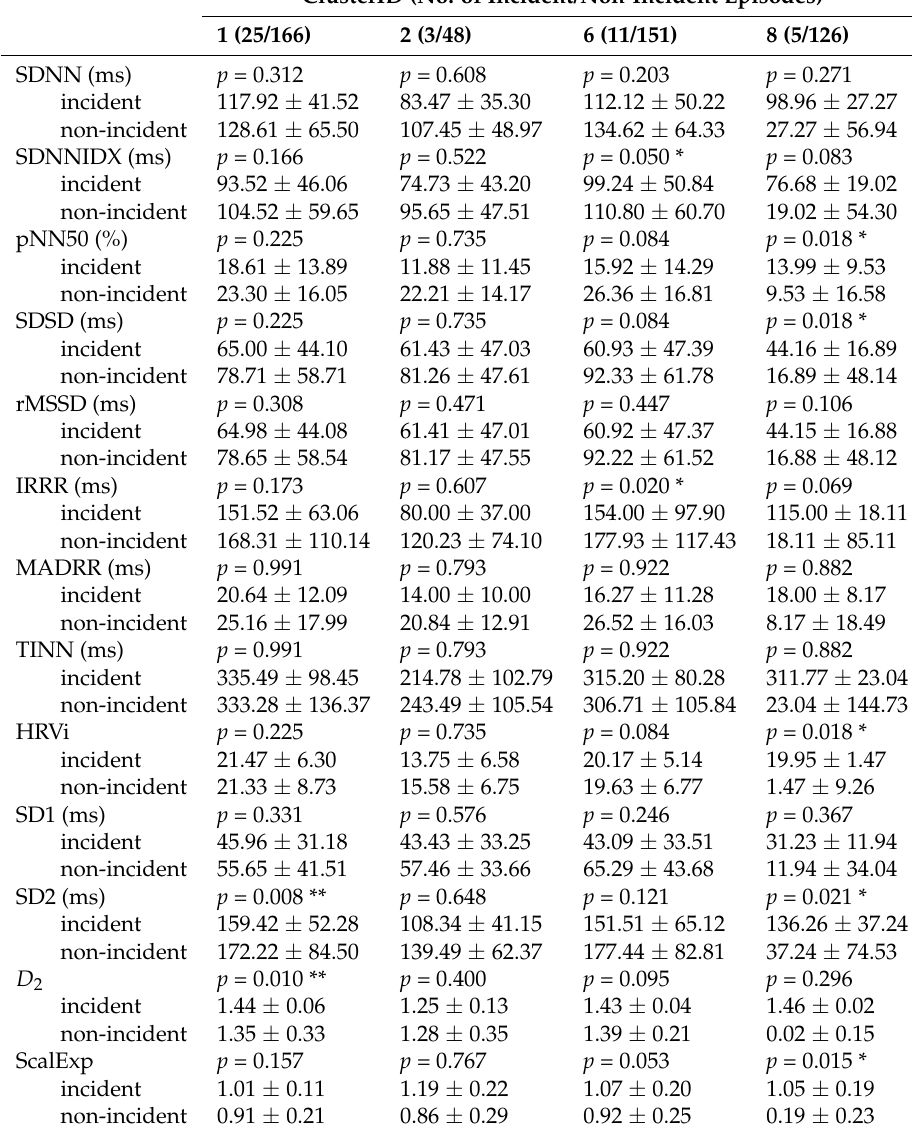
Table 3. Results of Welch’s t -test significance and values of compared means (with confidence intervals) for ’incident’ vs. ’non-incident’ episodes calculated for various HRV parameters within motion clusters that contained a sufficient number of ’incident’ events. Asterisks indicate statistically significant results: * p < 0.05; ** p <